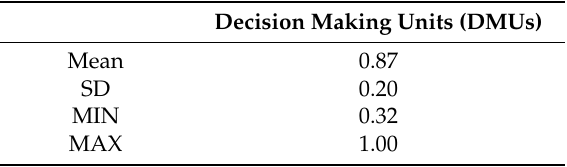
Table 4. Data Envelopment Analysis (DEA) Variable Return to Scale (VRS)